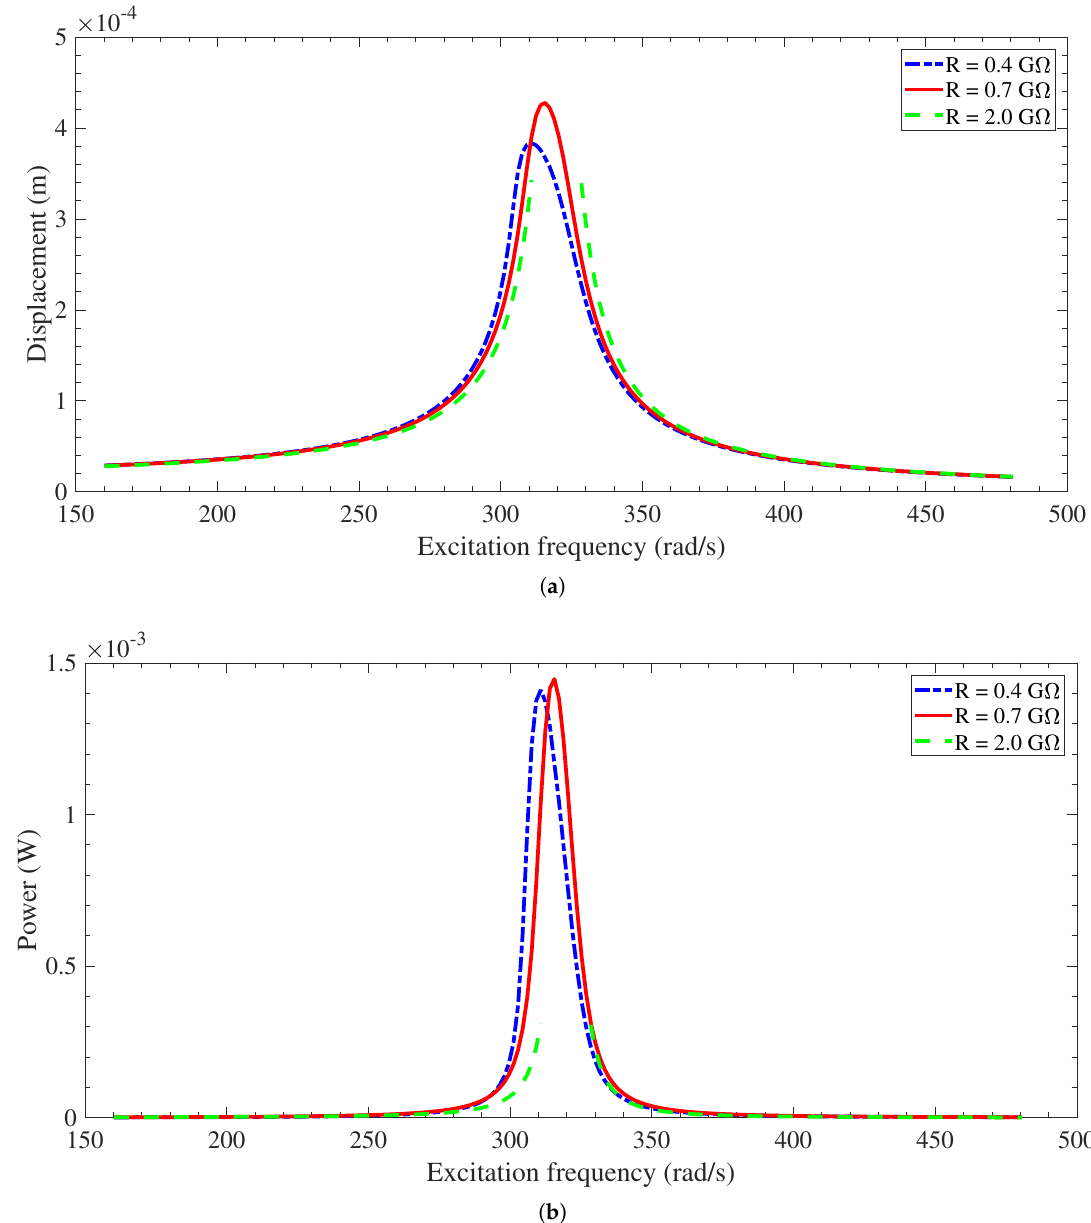
Figure 11. Frequency–response curves in terms of ( a ) displacement and ( b ) electrical harvested power for V et = 1400 V and F = 3 m/s 2